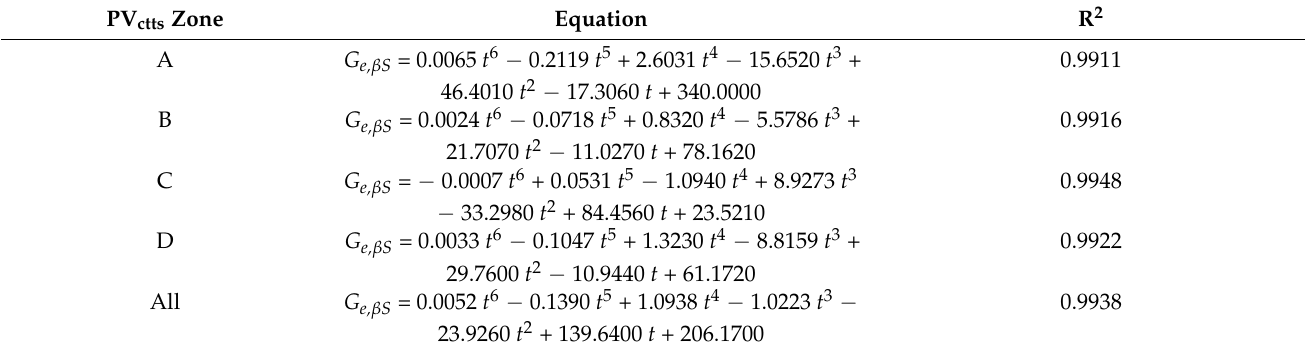
Table 6. Regression equations of the best-fit curves to the monthly mean G e, β S sums, averaged over all sites together with their R 2 values, where t is the month in the range 1–12 and β = 25 ◦ or 30 ◦ . PV ctts